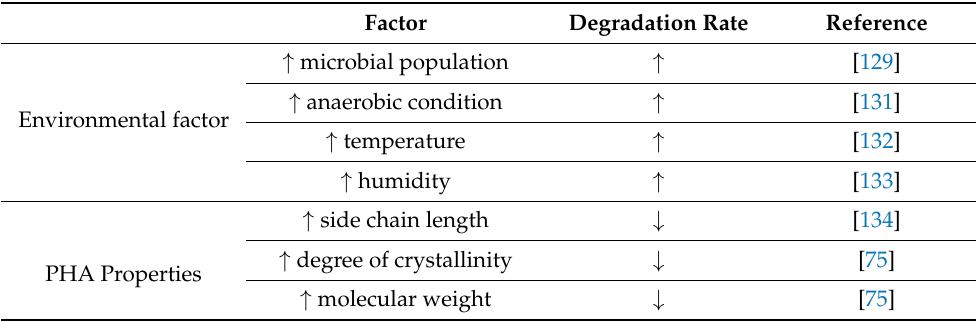
Table 2. Main correlations between the degradation rate and affecting factor of degradation. The ↑ symbol indicates an increase; the symbol ↓ indicates a